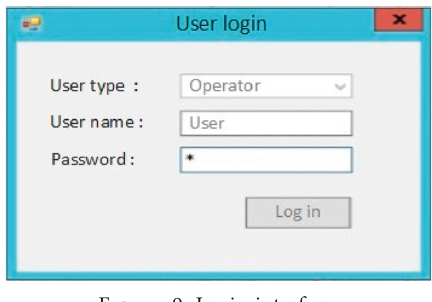
Figure 9: Login interface.